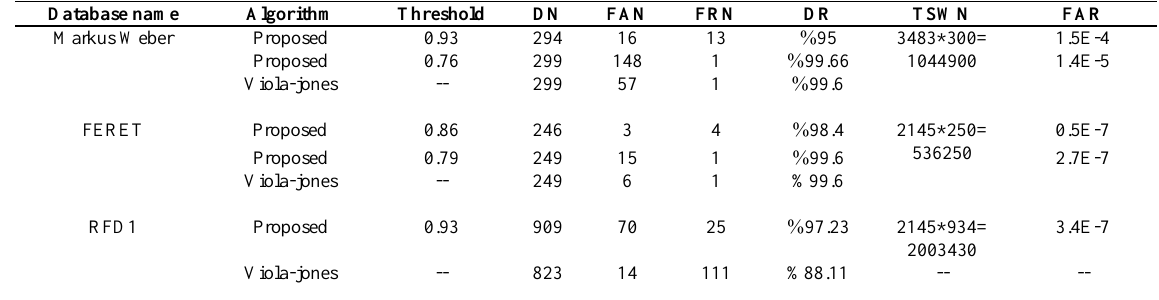
Table 2. A comparison between the results of face detection using the proposed and Viola-Jones algorithms on 1484 images collected from FERET, Markus Weber and RFD1 databases.